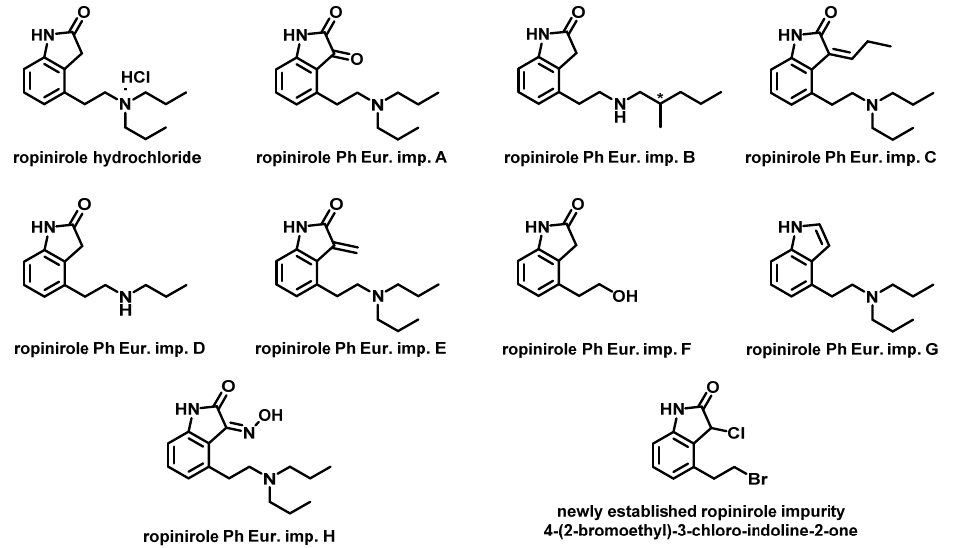
Figure 1. Structure of ropinirole hydrochloride, its process-related impurities defined in European Pharmacopeia [22] and the structure of 4-(2-bromoethyl)-3-chloro-indoline-2-one (chloro impurity). Although so far